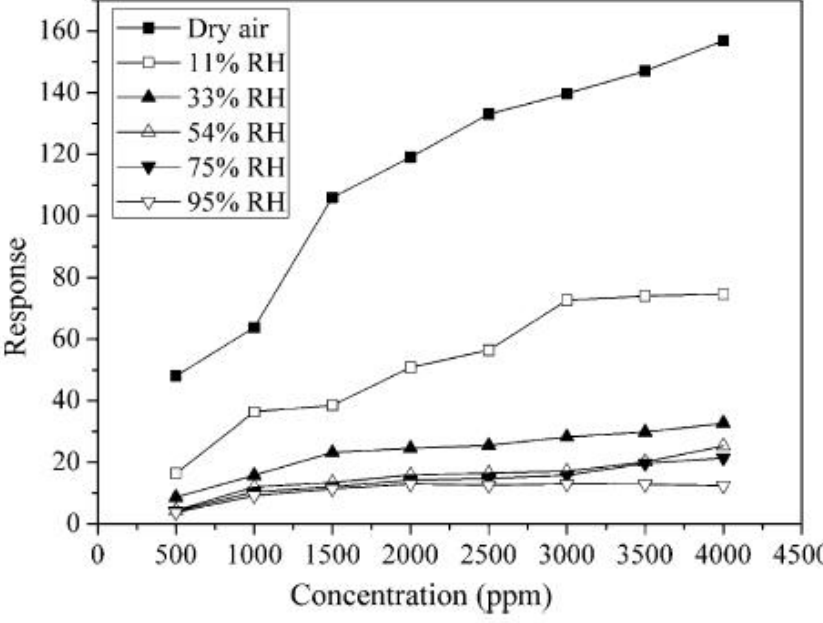
Figure 13. Response of the Sm at different RH (adapted from